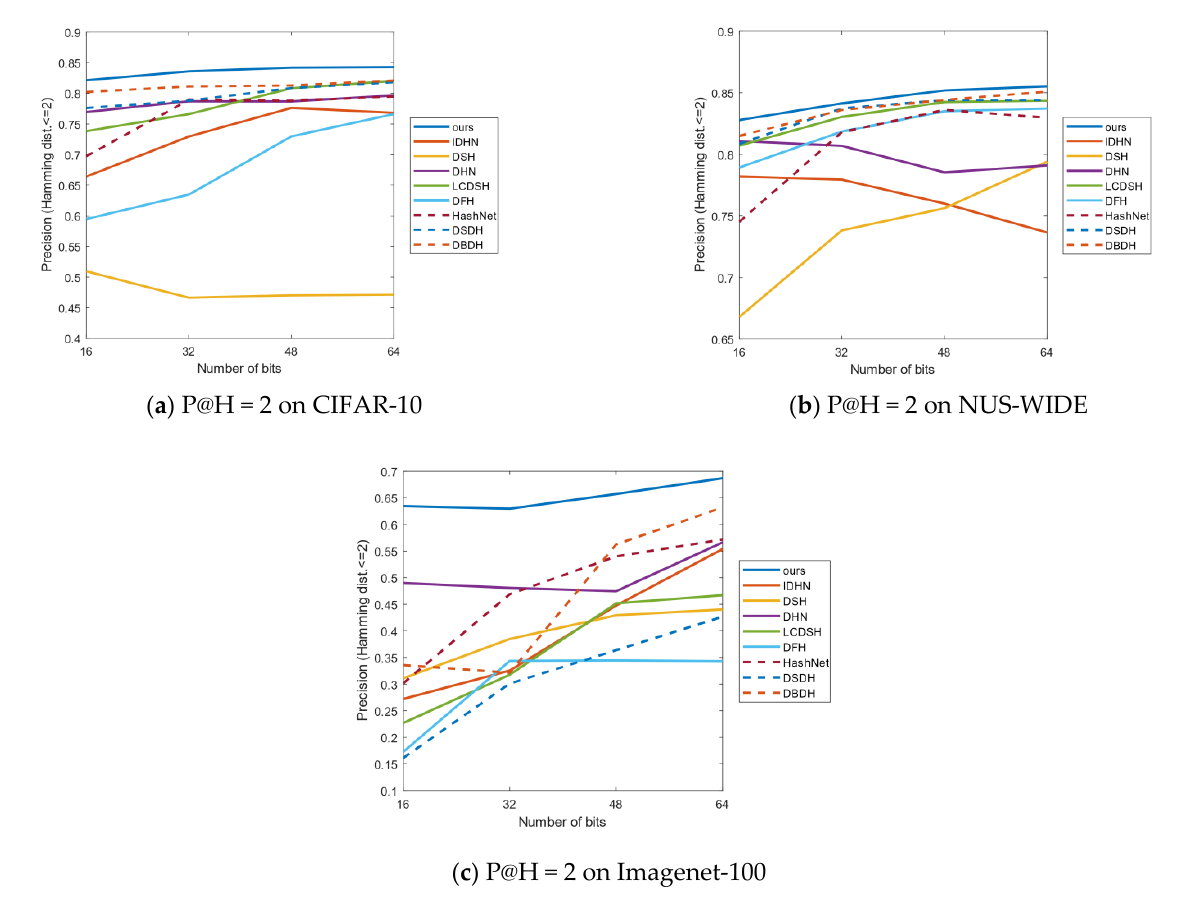
Figure 6. P@H = 2 on three data sets.